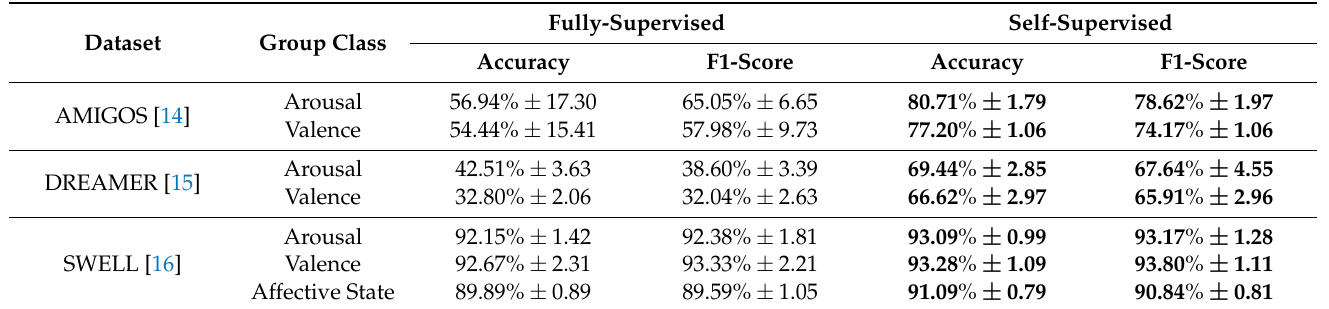
Table 6. Accuracy and F1-score results for emotion classification of the self-supervised model compared to fully supervised training of the same implemented neural